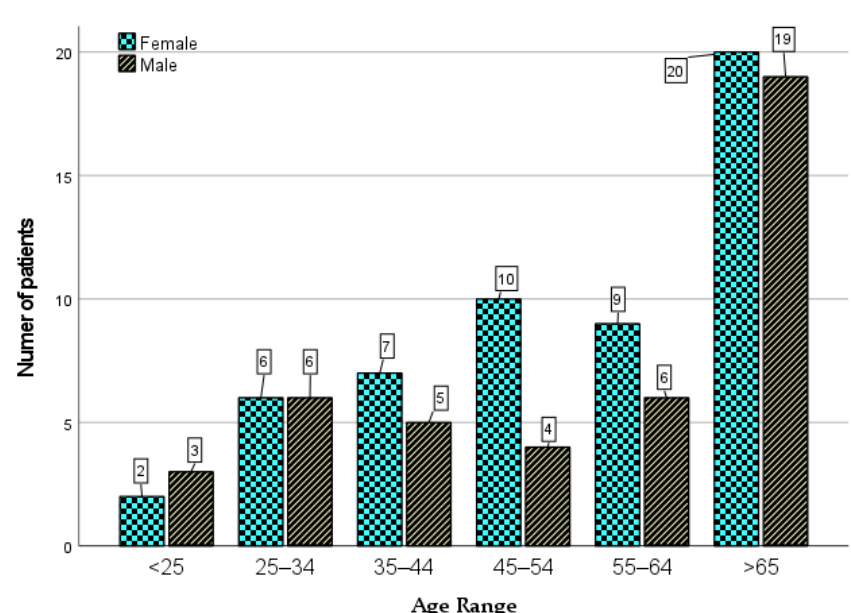
Figure 1. Patients’ age structure by gender.